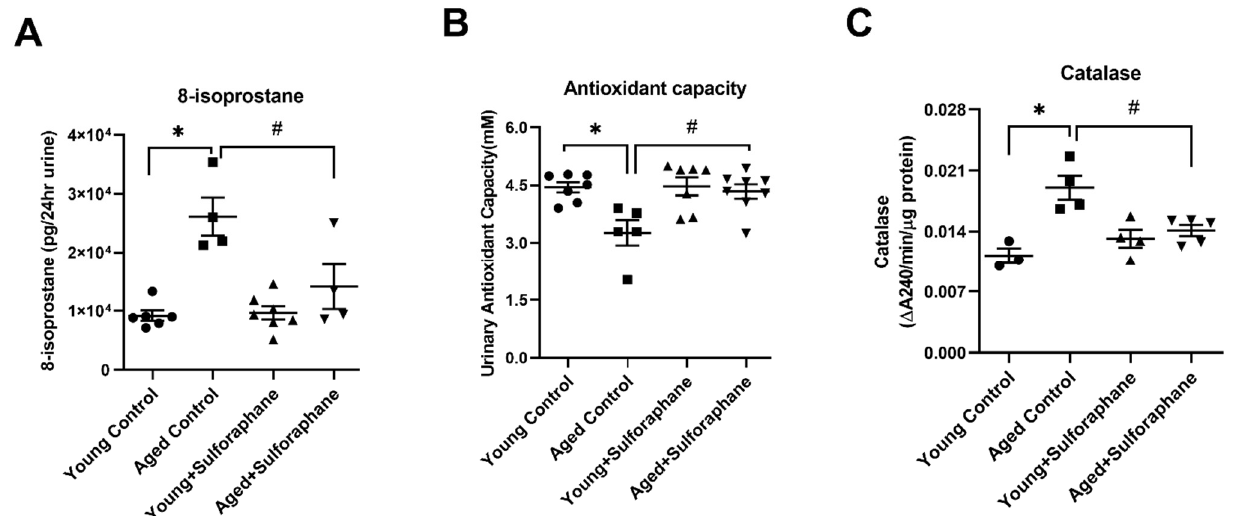
Figure 5. Sulforaphane decreases oxidative stress and improves antioxidant capacity in aged rats. ( A ) 8-isoprostane measured in 24 h urine. ( B ) Total antioxidant capacity measured in bladder urine. ( C ) Catalase activity measured in kidney cortex homogenates of young control (young F344 rats kept on tap water); aged control (aged F344 rats kept on tap water); young+sulforaphane (sulforaphane (15 mg/kg body wt/day) in drinking water); aged+sulforaphane. Results are presented as mean ± SEM, n = 3–5 rats for catalase, n = 3–6 rats for 8-isoprostane, and n = 4–6 rats for antioxidant capacity. * p < 0.05 significantly different from young control rats; # p < 0.05 significantly different from aged control rats, using 1-way ANOVA followed by Newman–Keuls post-hoc test.